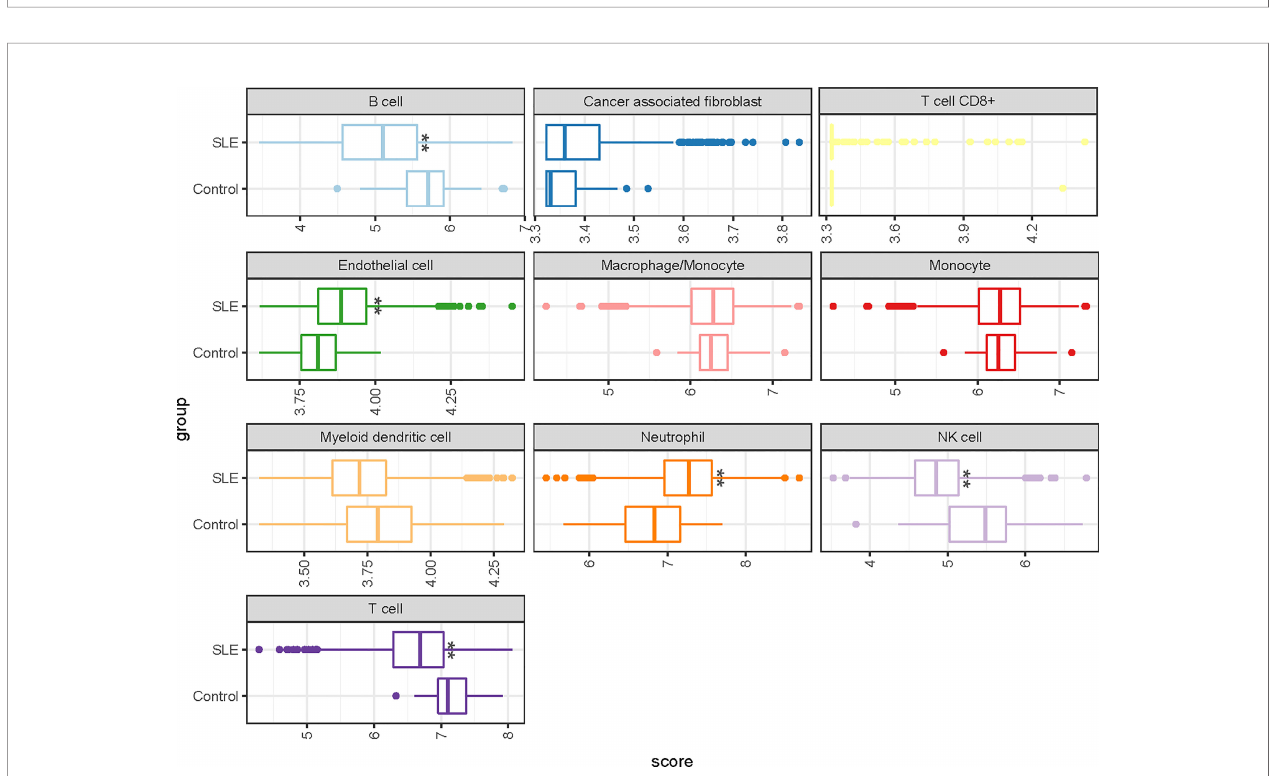
FIGURE 3 | A representative boxplot illustrating the analysis of the enrichment pro fi les of immune cells in deconvolution of cell mixtures (GSE65391). * P-value < 0.05; ** P-value <